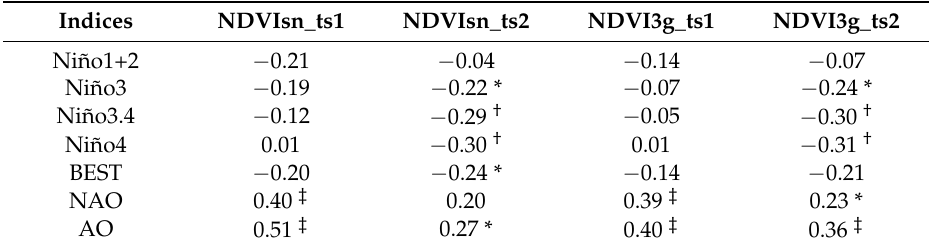
Table 2. Correlation coefficients between spring NDVI and various winter climate